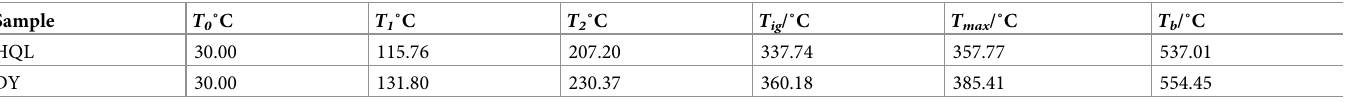
Table 2. Characteristic temperature of combustion of coal samples.